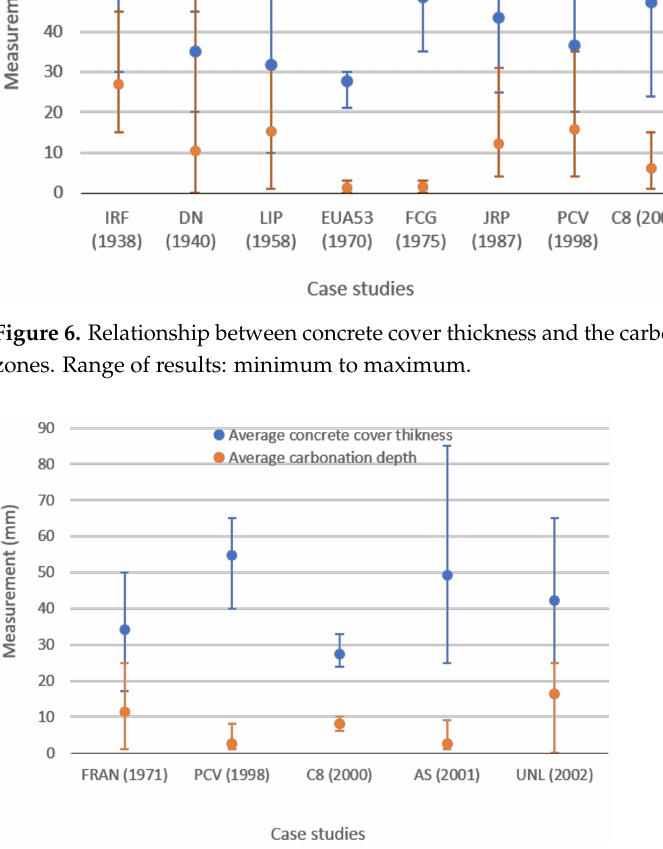
Figure 7. Relationship between concrete cover thickness and the carbonation depth in architectural concrete sampling zones. Range of results: minimum to